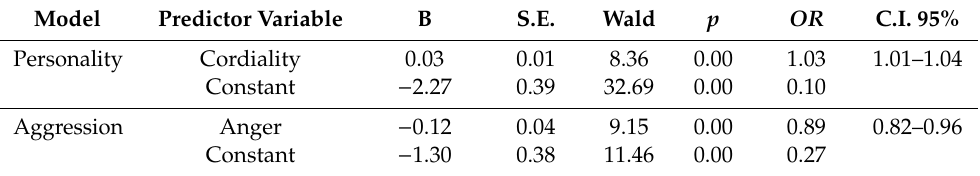
Table 4. Results from the binary logistic regression for the probability of being a victimized cyberbully. Model Predictor Variable B S.E. Wald p OR C.I. 95% Personality Cordiality